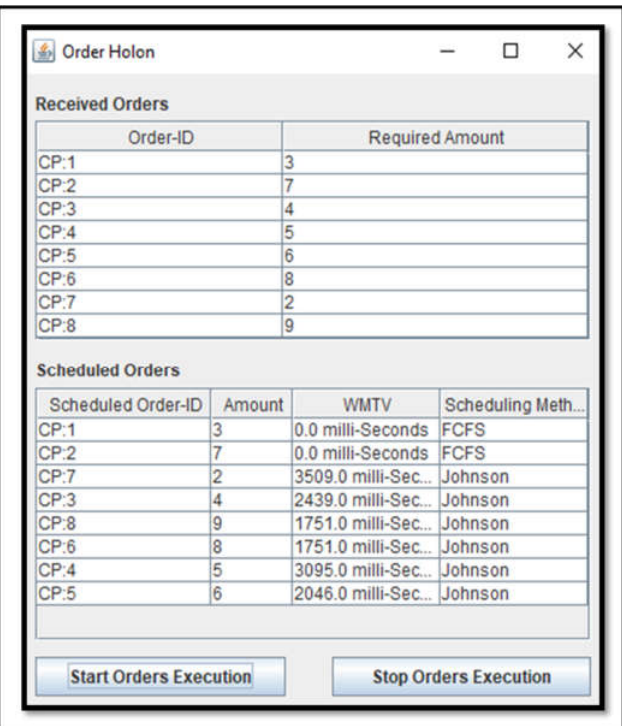
Figure 8. Case-study scheduling results.